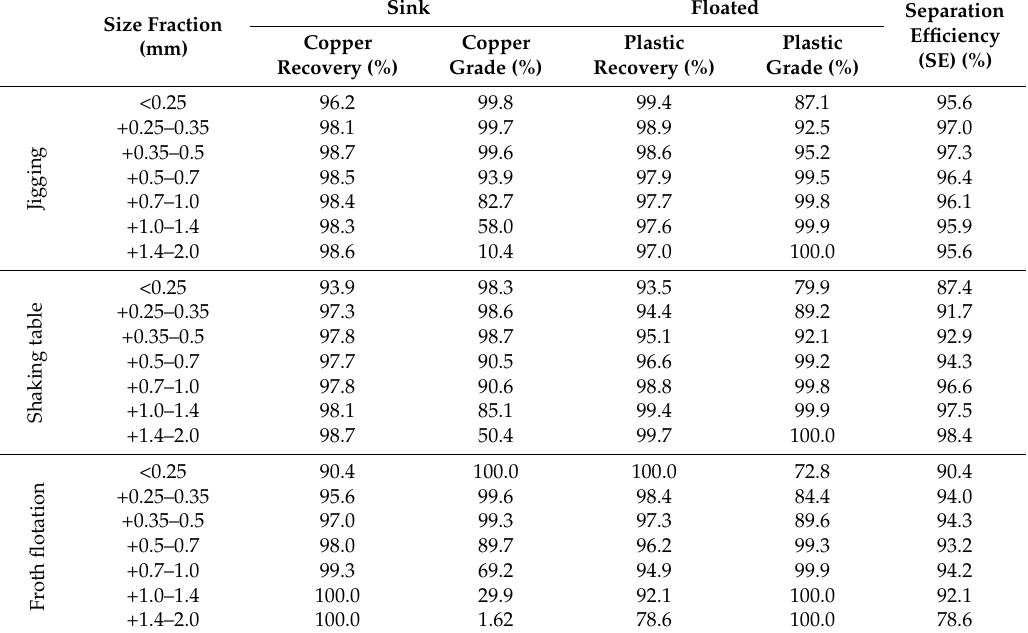
Table 5. Results of separation by jigging, shaking table and flotation of the copper/plastic mixture, for seven-sized